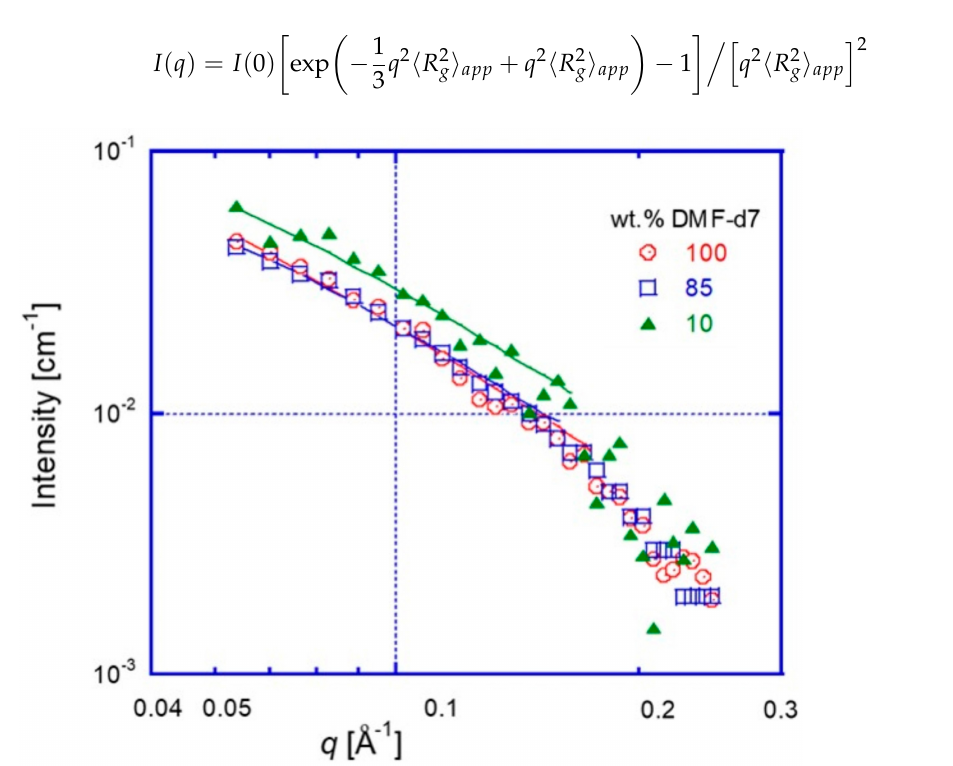
Figure 9. SANS patterns of 1 wt.% S 12 -b-4VP 12 solutions after background subtraction, in DMF solvent at DMF-d7 contents of: red circles: 100; blue squares: 85 and green diamonds: 10 wt.%. Solid lines are fits of the Guinier–Debye function, Equation